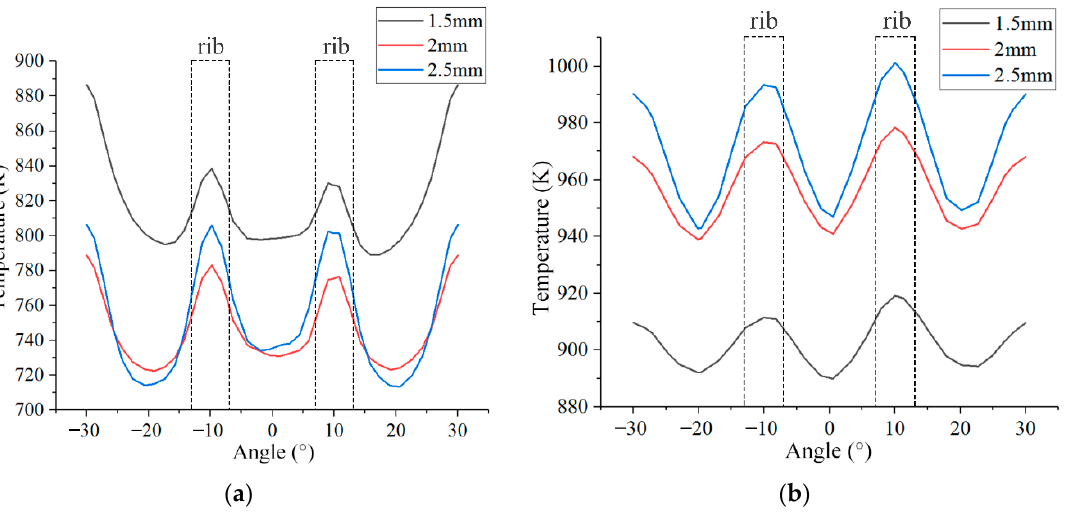
Figure 22. Circumferential variation in temperature on the inner wall under axial positions Z = 20 mm and Z = 175 mm. ( a ) Circumferential variation in temperature under Z = 20 mm; ( b ) circumferential variation in temperature under Z = 175 mm.